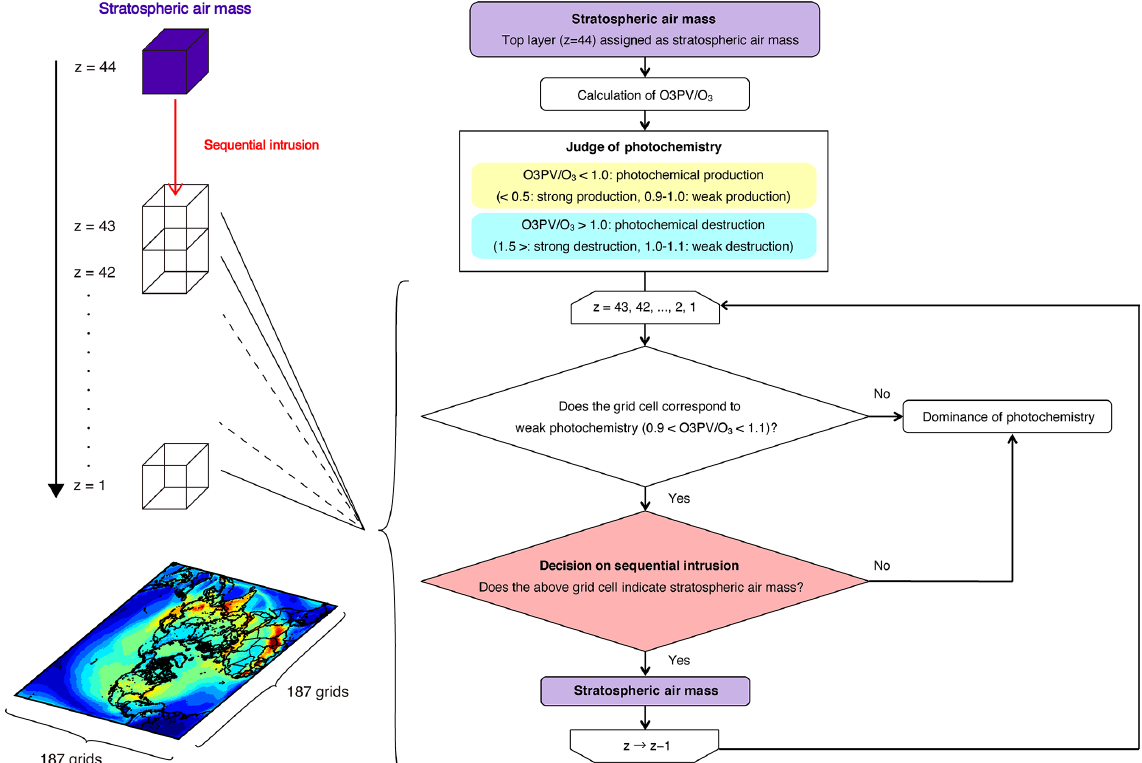
Figure 8. Flowchart of the air mass characterization scheme. See the text for additional